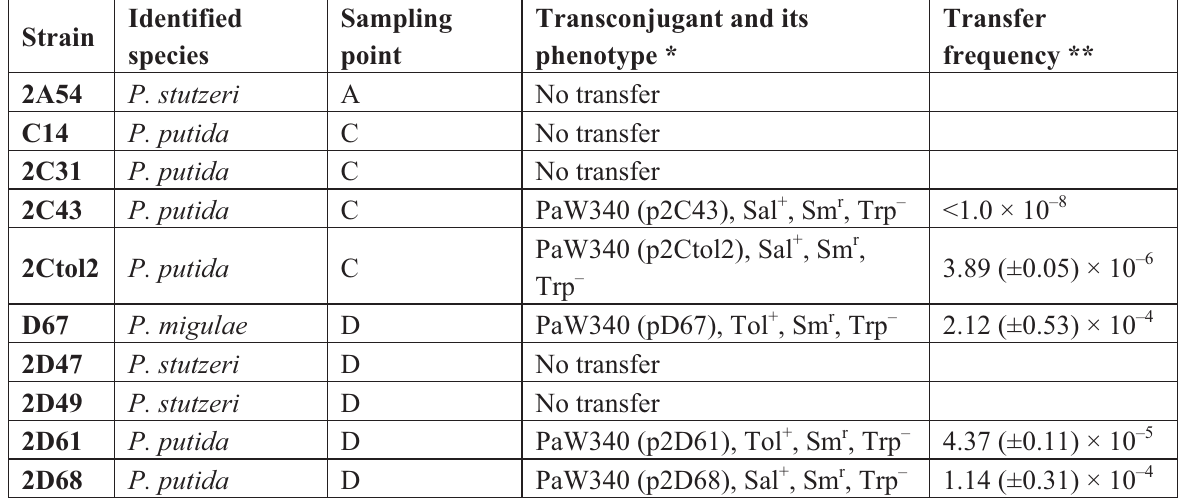
Table 3. Transferability of IncP-9 plasmids in mating experiments with P. putida